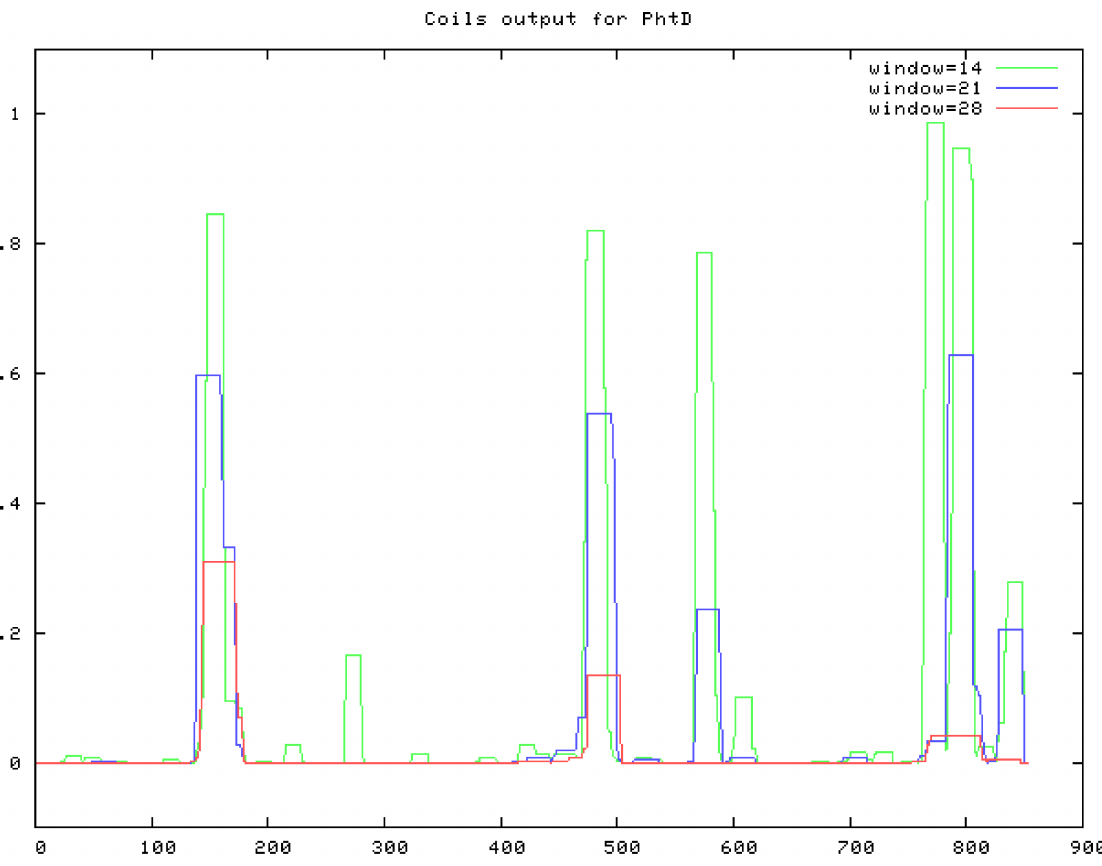
Figure 1. Coils prediction server output for PhtD. The Coils server (http://embnet.vital-it.ch/software/COILS_form.html) was used to compare the amino acid sequence of PhtD to a database of proteins known to form coiled-coils to yield a prediction of which regions (if any) will fold in this conformation. The x-axis represents the position in the protein by amino acid number (starting at the N-terminus) and the y-axis shows how strongly that region is predicted to form a coiled coil. ‘Window’ refers to the width of the amino acid ‘window’ that is scanned at one time.